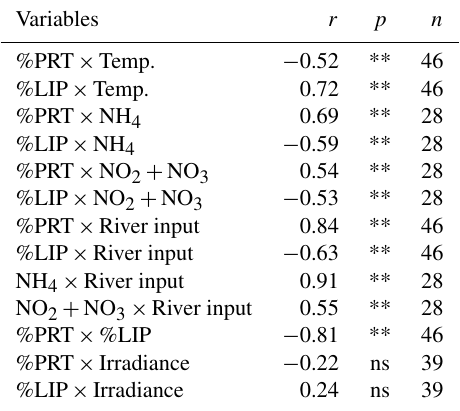
Table 6. The significant correlation coefficient ( r ) among proteins (PRT), lipids (LIP), and environmental factors (ns: no significance; ∗∗ : p < 0 . 01). River inputs were integrated from 20 days prior to our sampling dates.